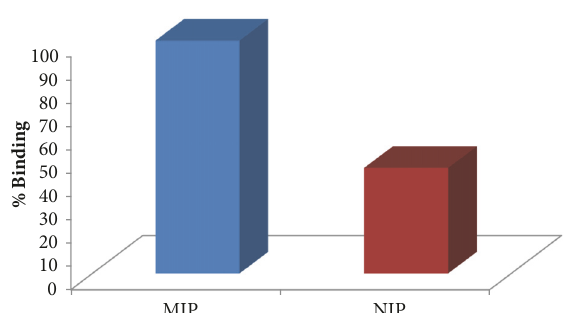
Figure 7: Extraction of myoglobin from human serum [C Mb : 0.1 𝜇 gmL −1 , m polymer : 20mg, pH: 7.0, t: 1 h, T: 25